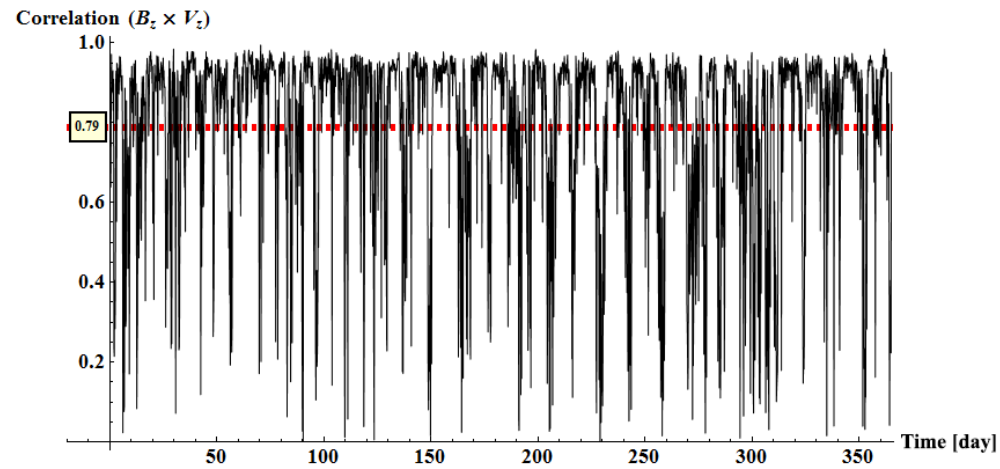
Figure 5. 4h windowed Pearson cross-correlation between the solar wind velocity z component and the IMF z component ( V z − B z ) versus time for the whole year of 2003, at 0h